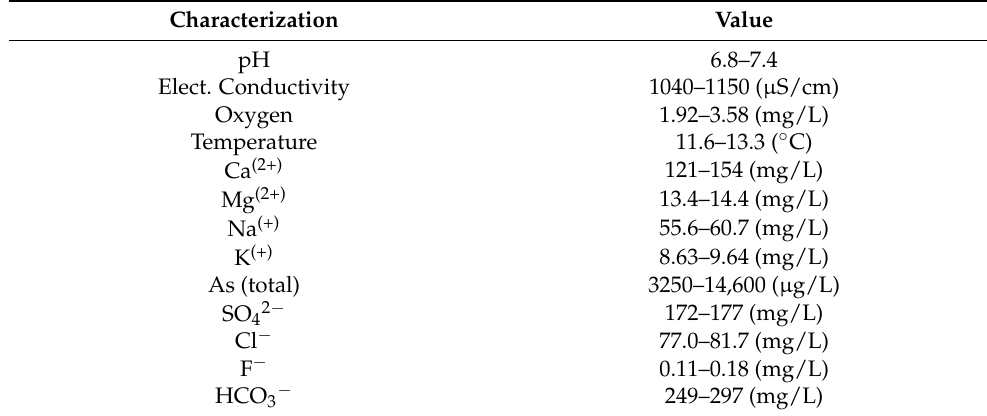
Table 1. Characterization of the water used in the experiments. HCO 3 − was calculated from measured inorganic carbon.